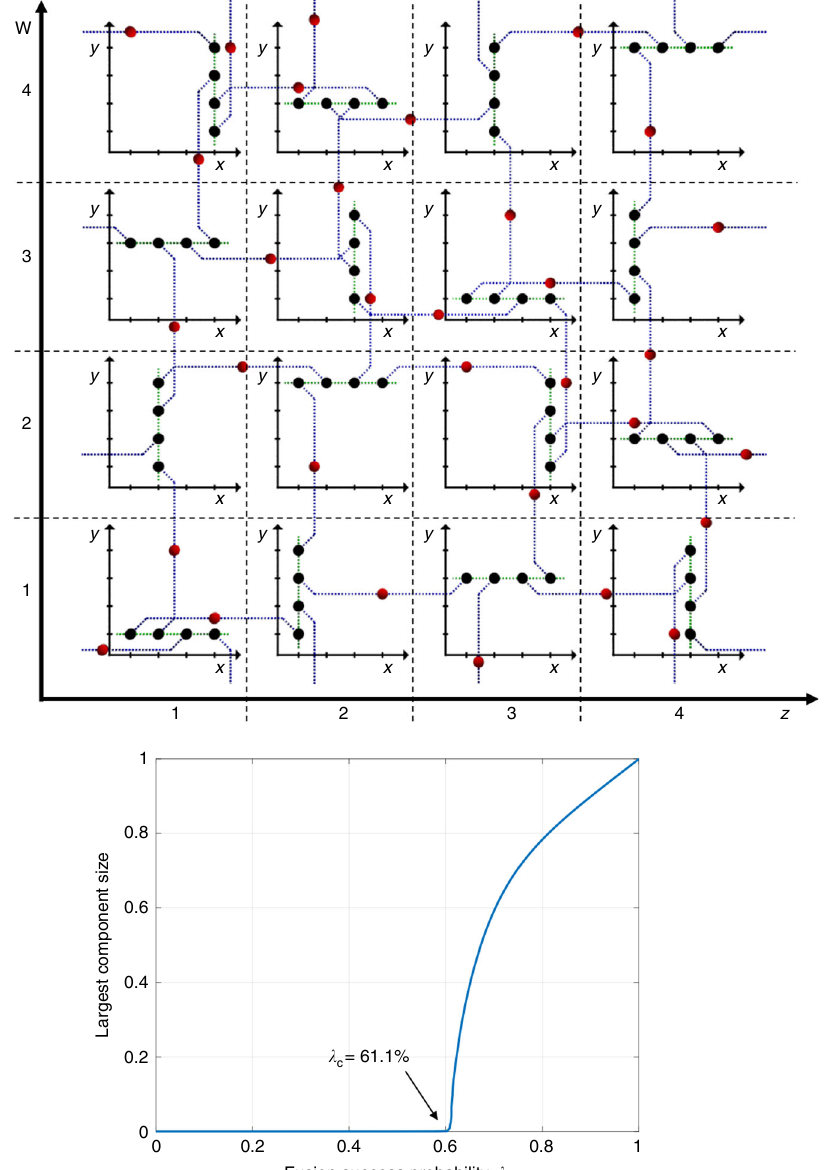
Fig. 6 Schematic of the 4D extension of the (10,3)-b lattice. The inner plots with x and y axes represent projections of the lattice on the ( x , y ) plane at the z and w values shown on the outer